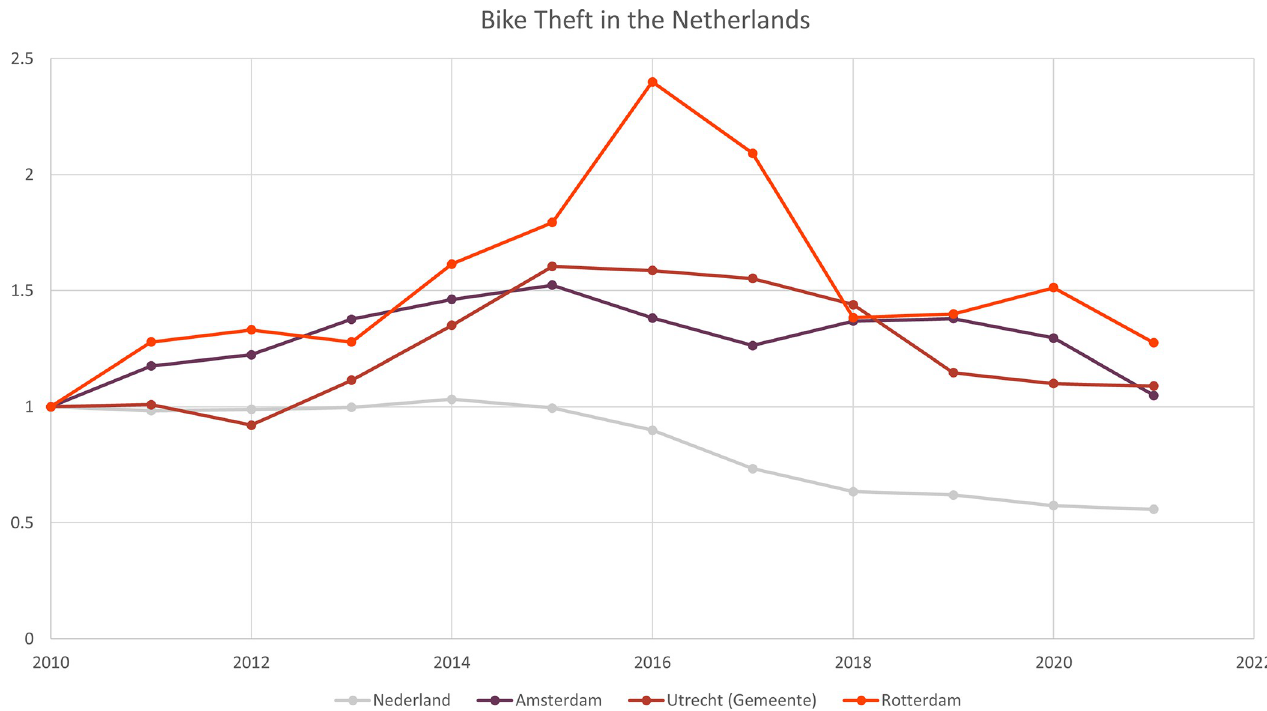
Fig 1. Reported bike thefts in the Netherlands, Amsterdam, Utrecht (municipality), and Rotterdam (2010 = 1). Data from 2020 and 2021 are preliminary. Data by [15].